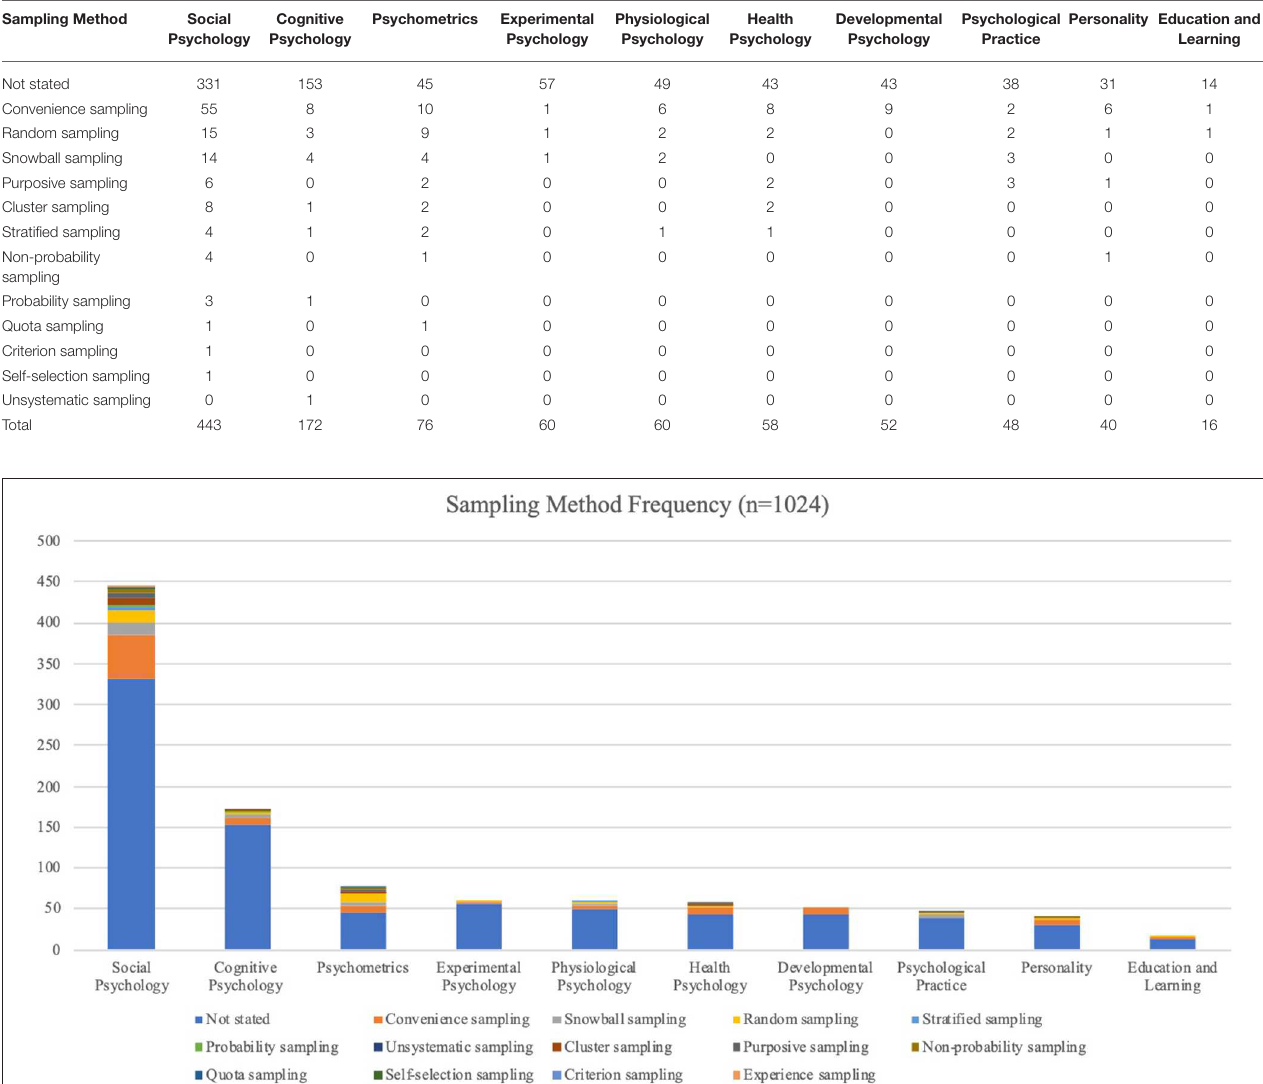
TABLE 3 | Sampling use in the field of psychology.